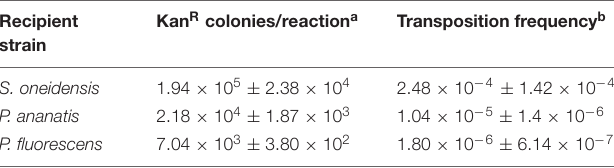
TABLE 4 | mini-ISY100 transposition frequency in different species.